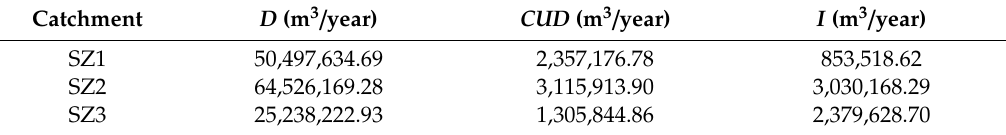
Table 10. Main variables of water balance for the optimal combination of SUDs.